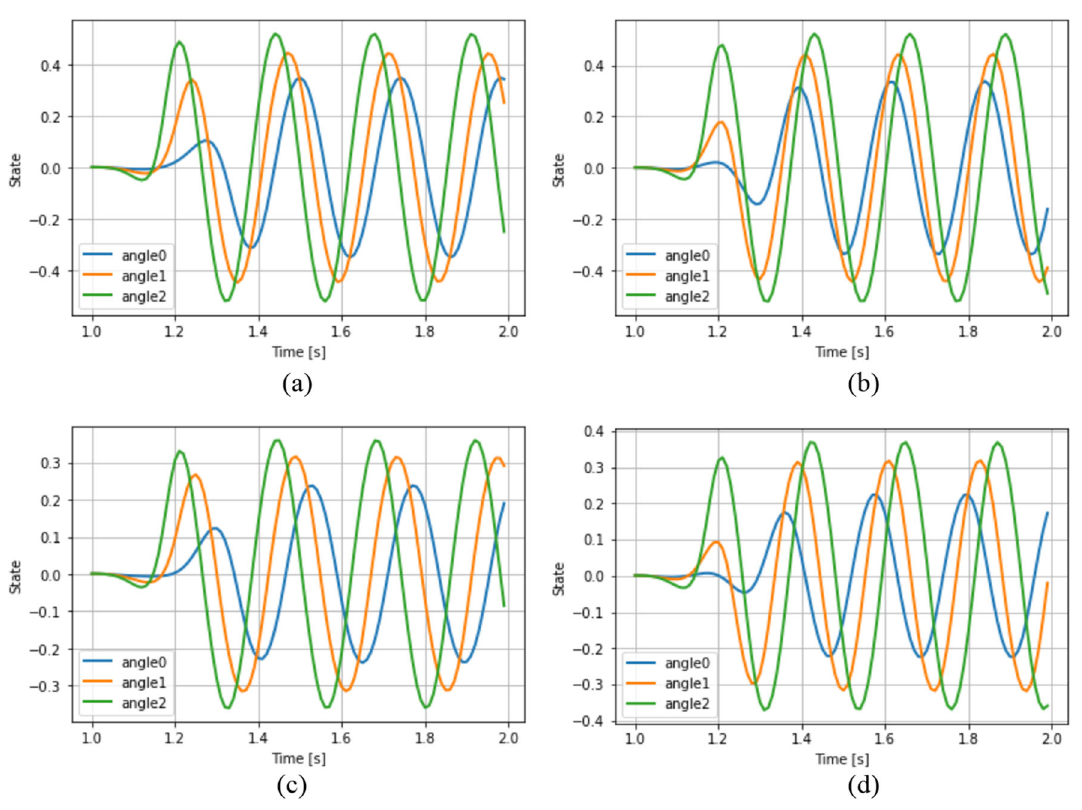
Fig.7 Theoutputanglewithdifferentparameters.Givingtheparameter values as a a = 5 . 0, b = 1 . 0, θ = − 75 ◦ , A 1 = 10 , A 2 = 21 , A 3 = 30, and ω = 27 , k = 11. b a = 5 . 0, b = 1 . 0, θ = 60 ◦ , A 1 = 10 , A 2 =